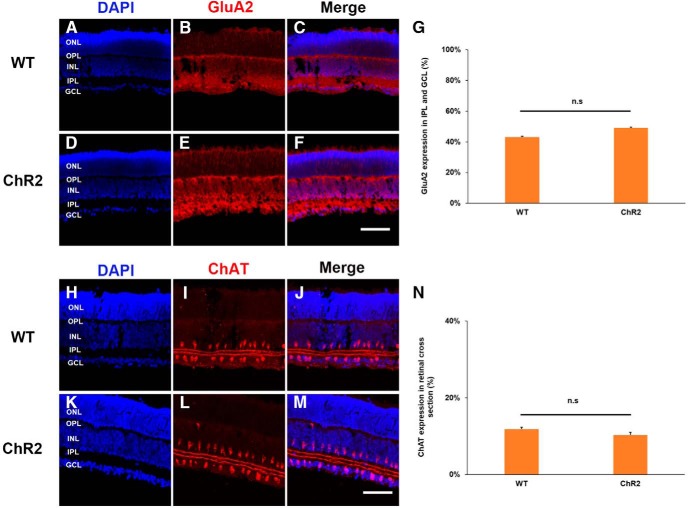
Neural developments of WT and ChR2 retinas are relatively normal in P11 mice. A–F, A vertical section through P11 WT and ChR2 mouse retinas. DAPI was used to indicate nuclei in the retinal slice (blue), and GluA2 was used to label AMPA receptors (red). Scale bar, 100 μm. G, GluA2 showed a similar expression level in both WT and ChR2 retinas. H–M, A vertical section through P11 WT and ChR2 mouse retinas. Similarly, DAPI was used to indicate nuclei in the retinal slice (blue), and ChAT was used to label cholinergic amacrine cells (red). Scale bar, 100 μm. N, ChAT also showed a similar expression level in both WT and ChR2 retinas. Taken together, these findings demonstrate that the effect of blue light stimulation on neurite outgrowth in ChR2 mice is not a result of maturation defect (n = 4 for WT; n = 5 for ChR2). n.s, p > 0.05. Error bars, mean ± SEM.